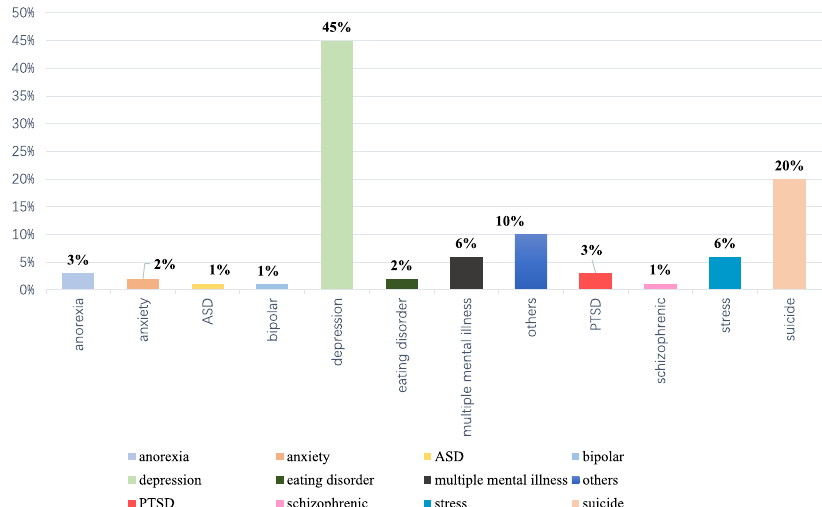
Fig. 5 Proportions of various types of mental illness. The chart depicts the percentages of different mental illness types based on their